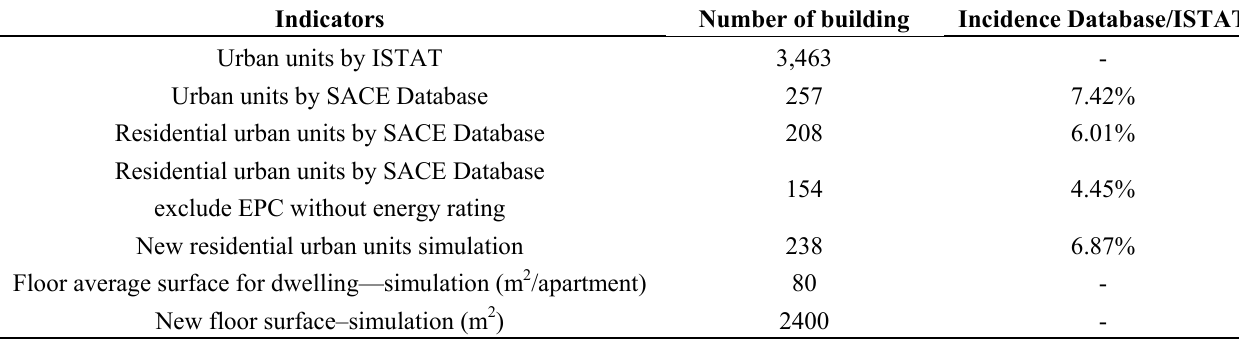
Table 5. Verucchio: ISTAT Data, SACE Database and simulation